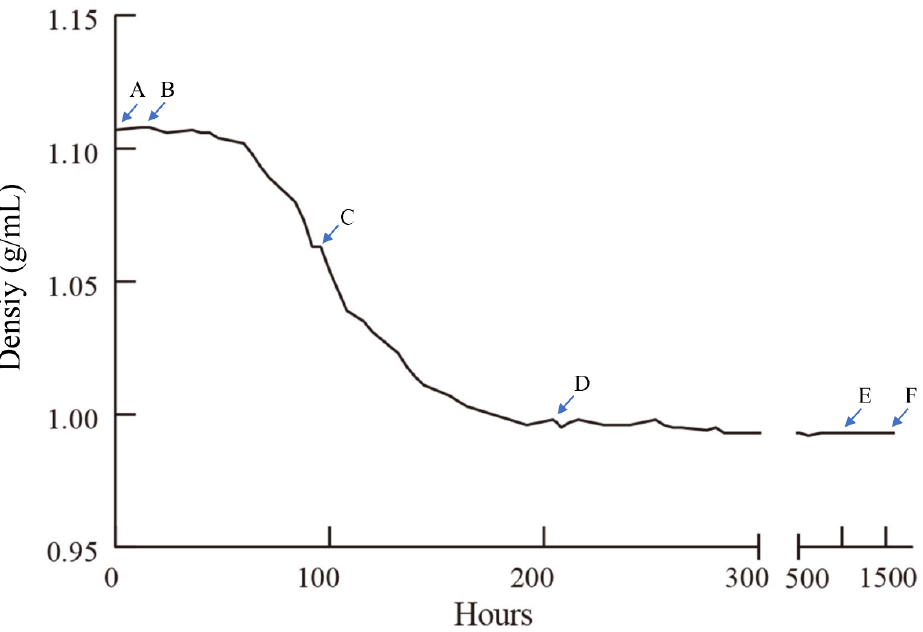
Figure 2. Fermentation curve and sampling intervals of Beimei red winemaking. Stage A (0.5 h, Density 1.107 g/mL, after grape crushed). Stage B (12 h, Density 1.108 g/mL, after SO 2 added). Stage C (93 h, Density 1.063 g/mL, middle AF). Stage D (206 h, Density 0.997 g/mL, between AF and MLF). Stage E (1099 h, Density 0.993 g/mL, middle MLF). Stage F (1598 h, Density 0.993 g/mL, after MLF).